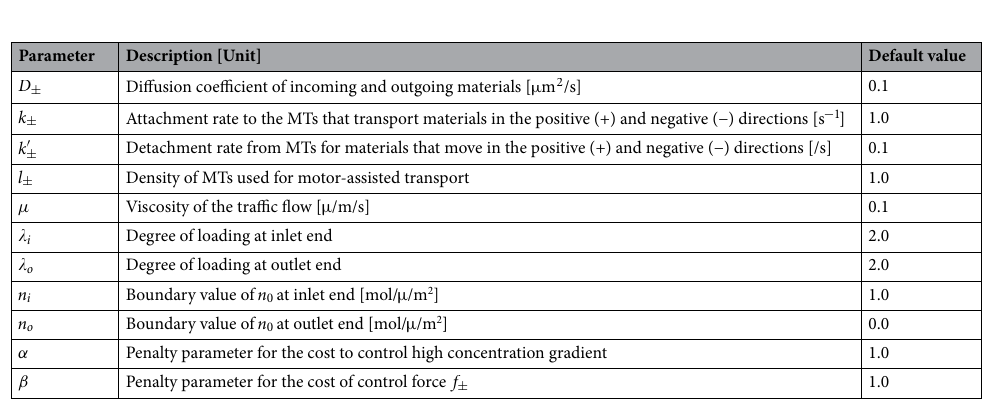
Table 1. Simulation parameters utilized in